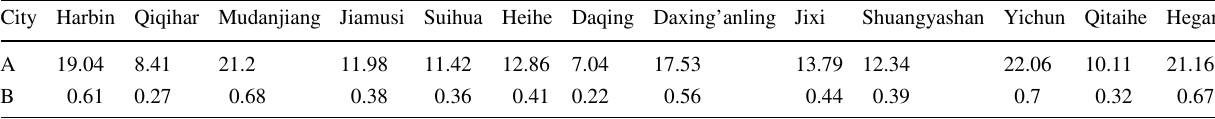
A is average runoff modulus, B is water resources yield Table 2 The ECC of surface water, groundwater and the overall water resources of cities